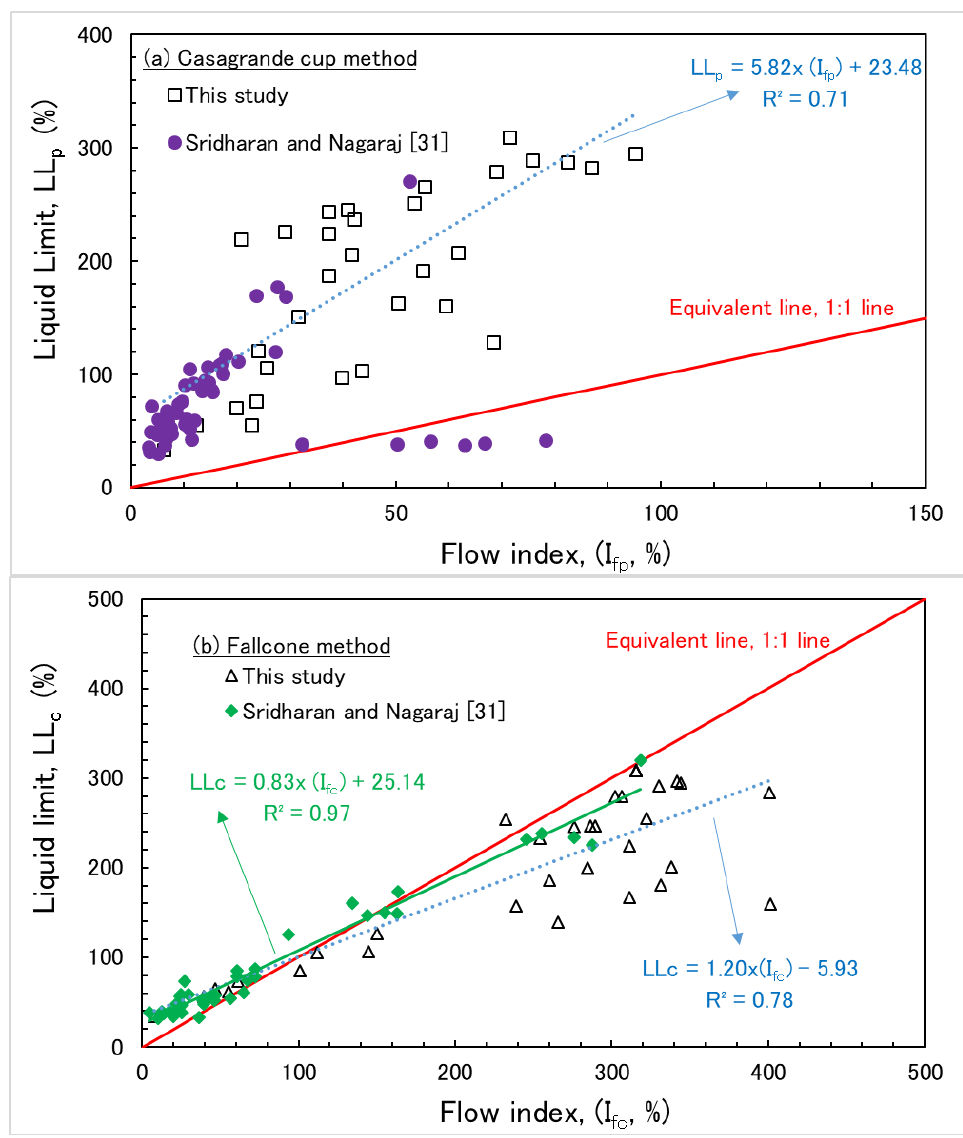
Figure 7. Relationship between flow index and liquid limit using the ( a ) Casagrande cup method and the ( b ) Fall cone method.